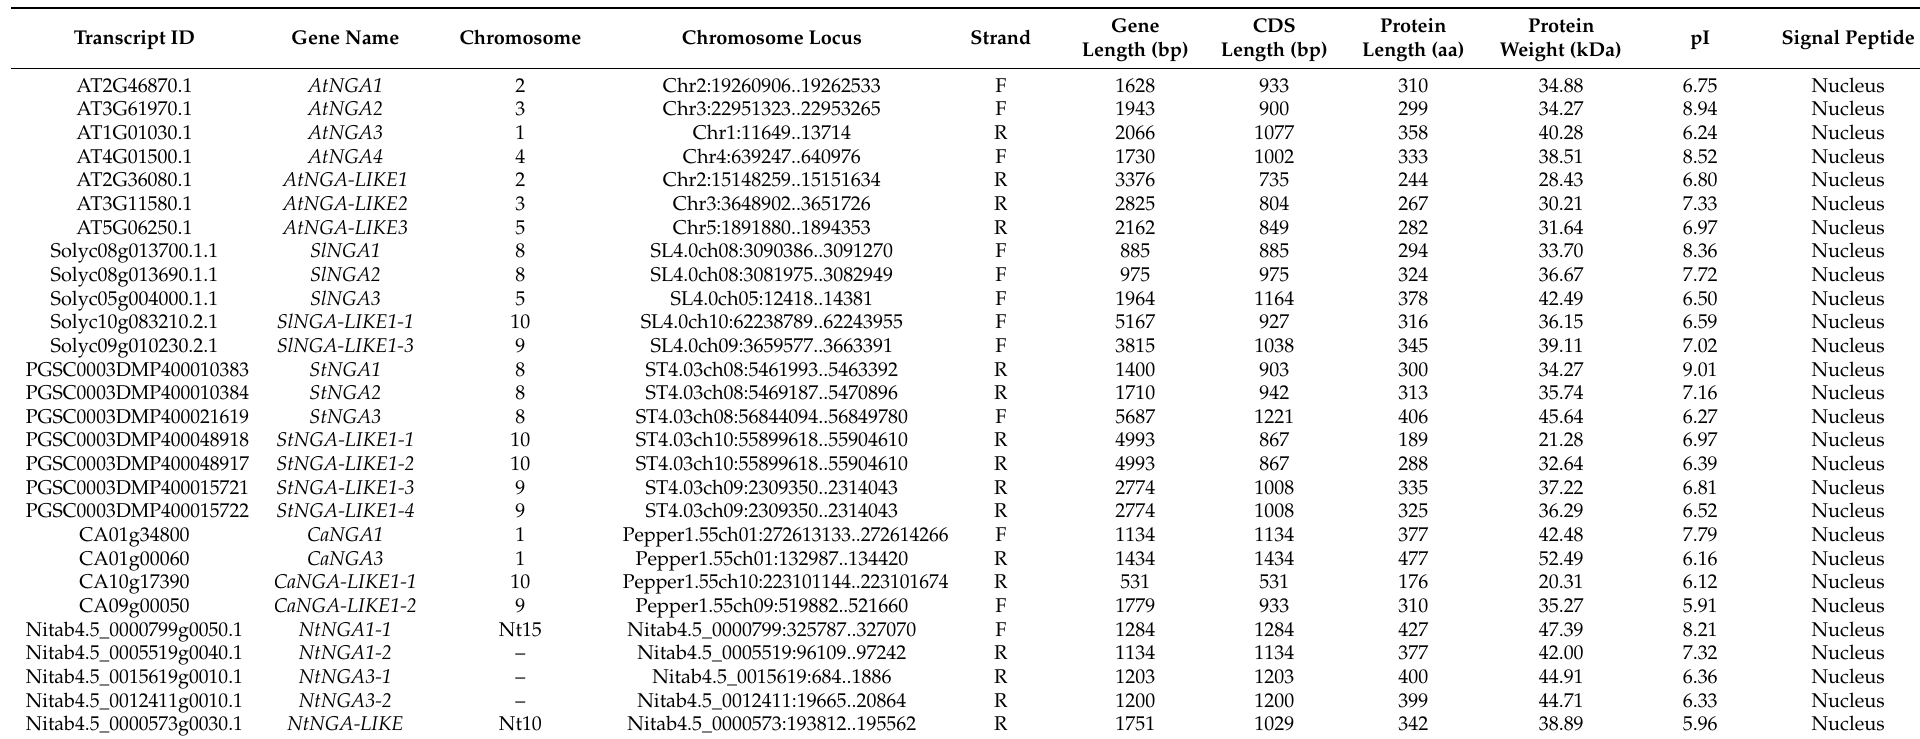
Table 1. The list of NGATHA genes in Arabidopsis and Solanaceae (tomato, potato, capsicum, and tobacco) and the features of each gene and